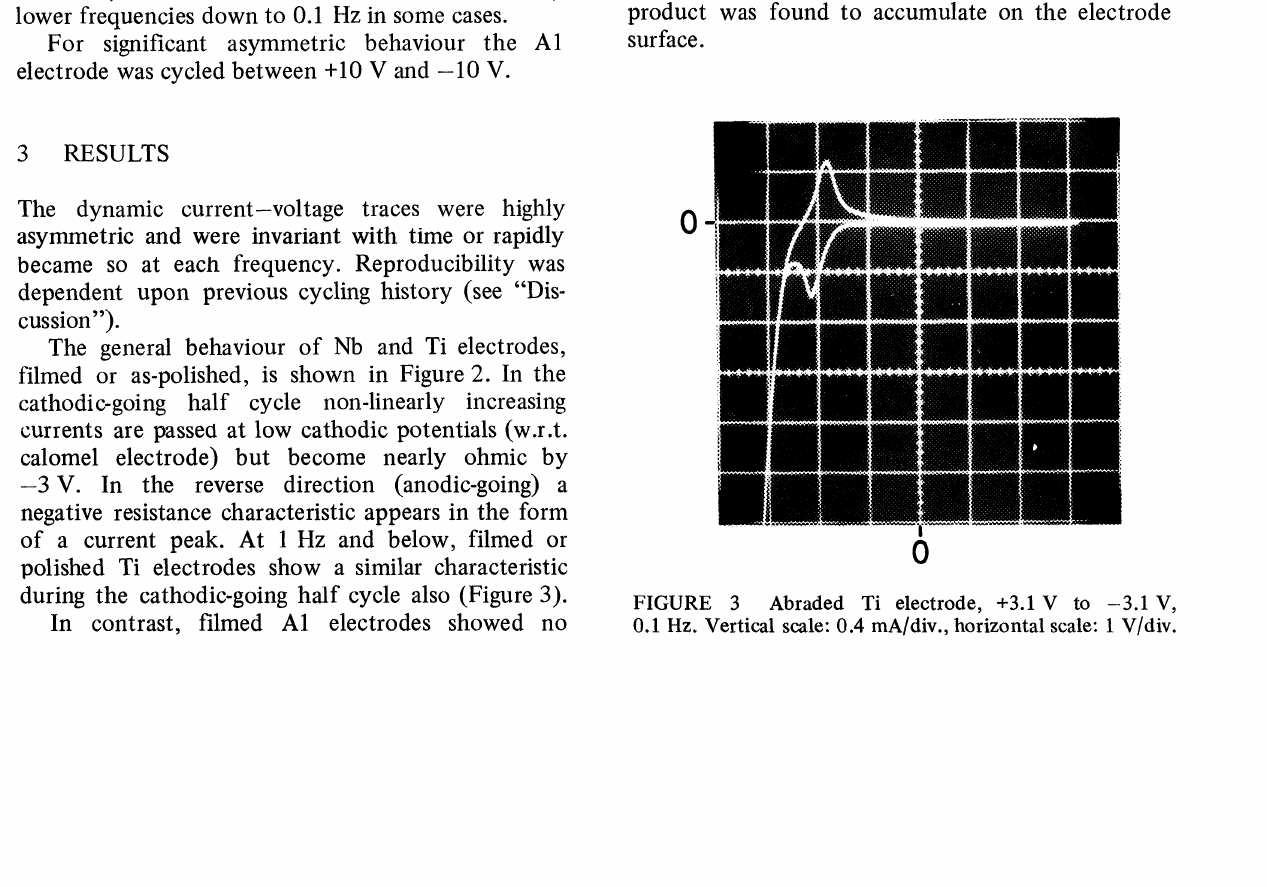
FIGURE Block diagram: G Triangular waveform gener- ator, P Potentiostat, CRO Cathode ray oscilloscope, we working electrode, ce counter electrode, ref reference electrode. vertically (after differential amplification) on an oscilloscope (Tektronix 502A) against a horizontal voltage deflection. Traces were recorded photo- graphically.